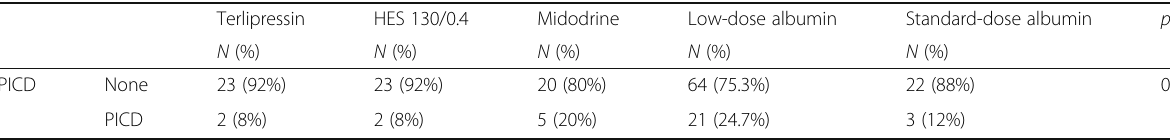
Table 4 Comparison of different treatment protocols for the PICD prevention Terlipressin HES 130/0.4 Midodrine Low-dose albumin Standard-dose albumin